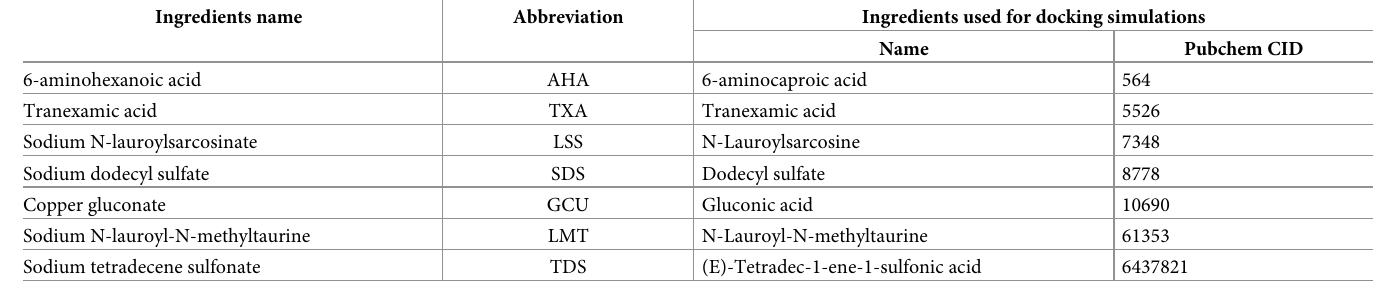
Table 2. Test ingredients subjected to docking